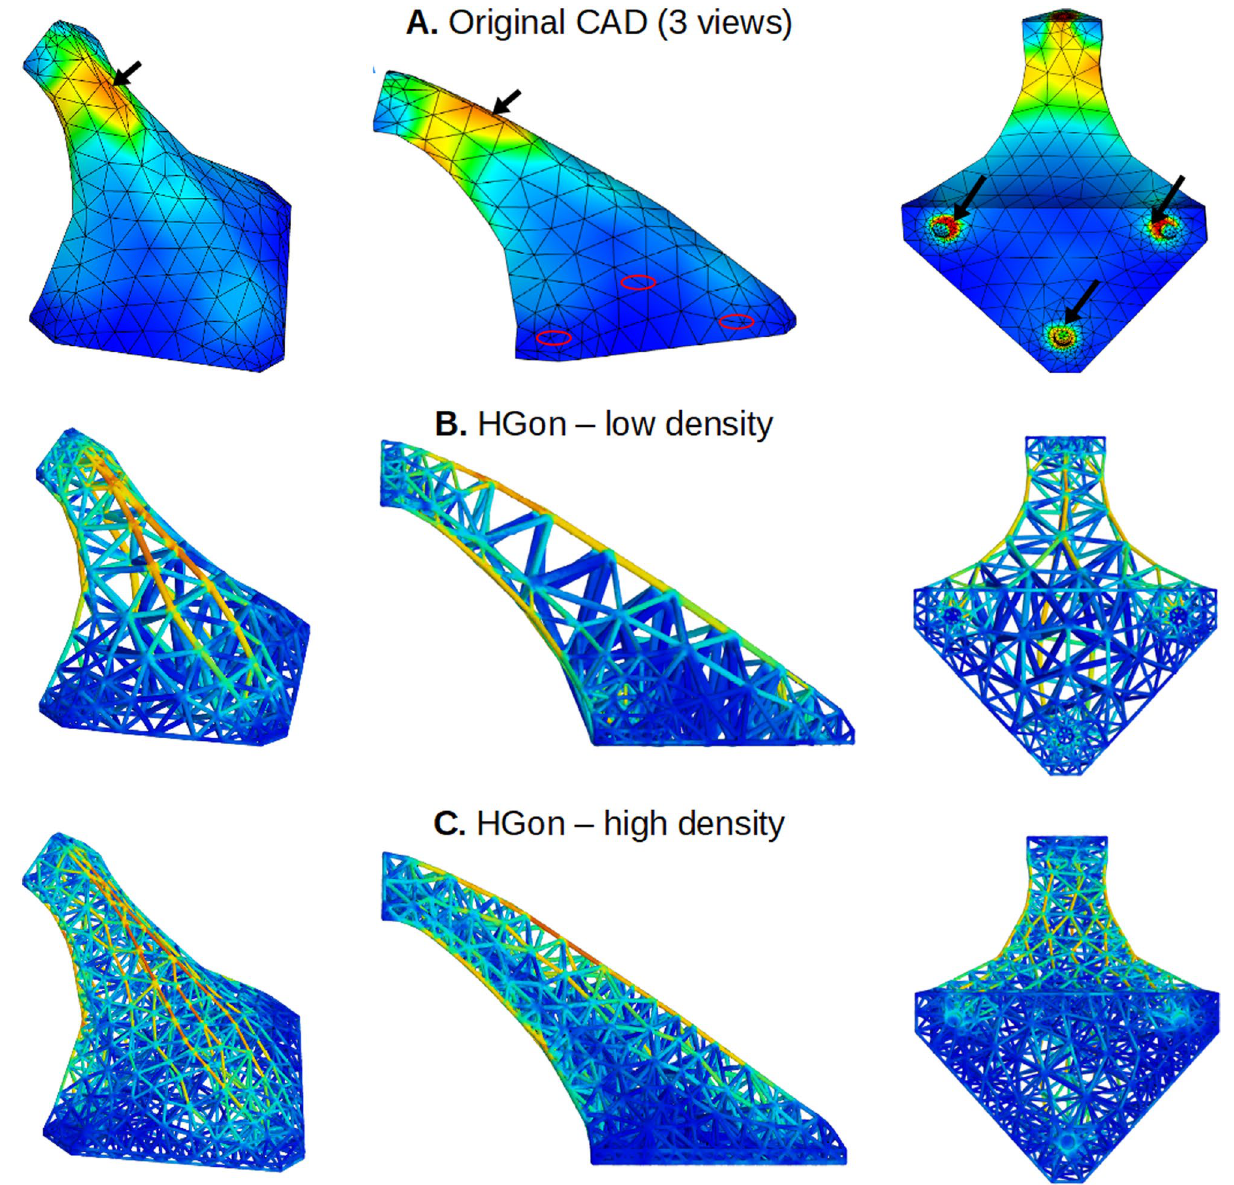
Figure 13. Three orthotropic views (oblique, side, bottom) of the original CAD ( A ) and the three HGon meta- structure FE meshes ( B – D ) showing maps of von Mises stresses (0–70 MPa range) at peak (pre-release) load. The black arrows in ( A ) indicate locations of high stress used for the stress-time plots in subsequent